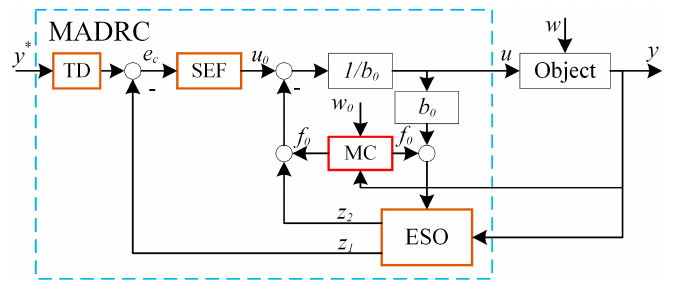
Figure 4. Block diagram of the MADRC .